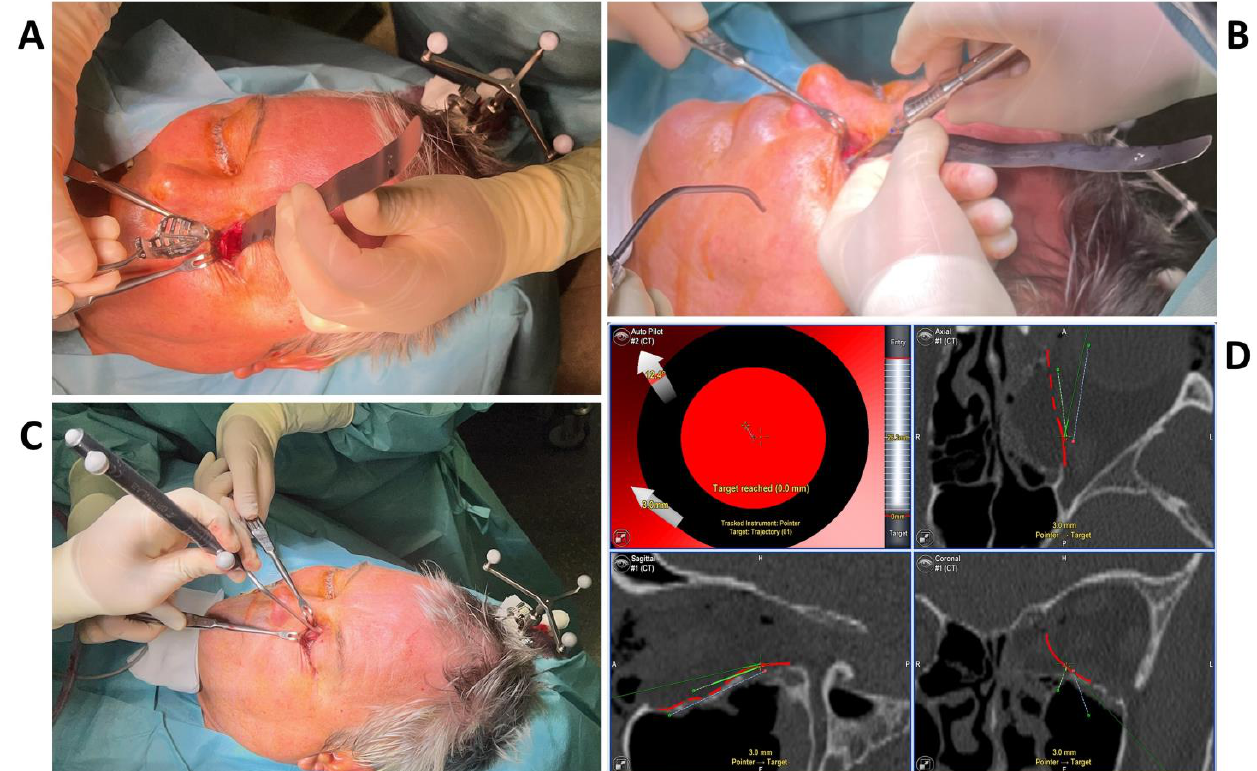
Figure 3. The intraoperative photographs show the preparation of the left orbit via a transconjunctival incision and insertion of the patient-specific implant ( A ), which is fixed with one 4 mm osteosynthesis screw at the infraorbital rim ( B ). Intra-operative real-time navigation using a navigation probe to follow the grooves on the implant ( C ) confirm the correct implant positioning by reaching the target of the set trajectories ( D ).